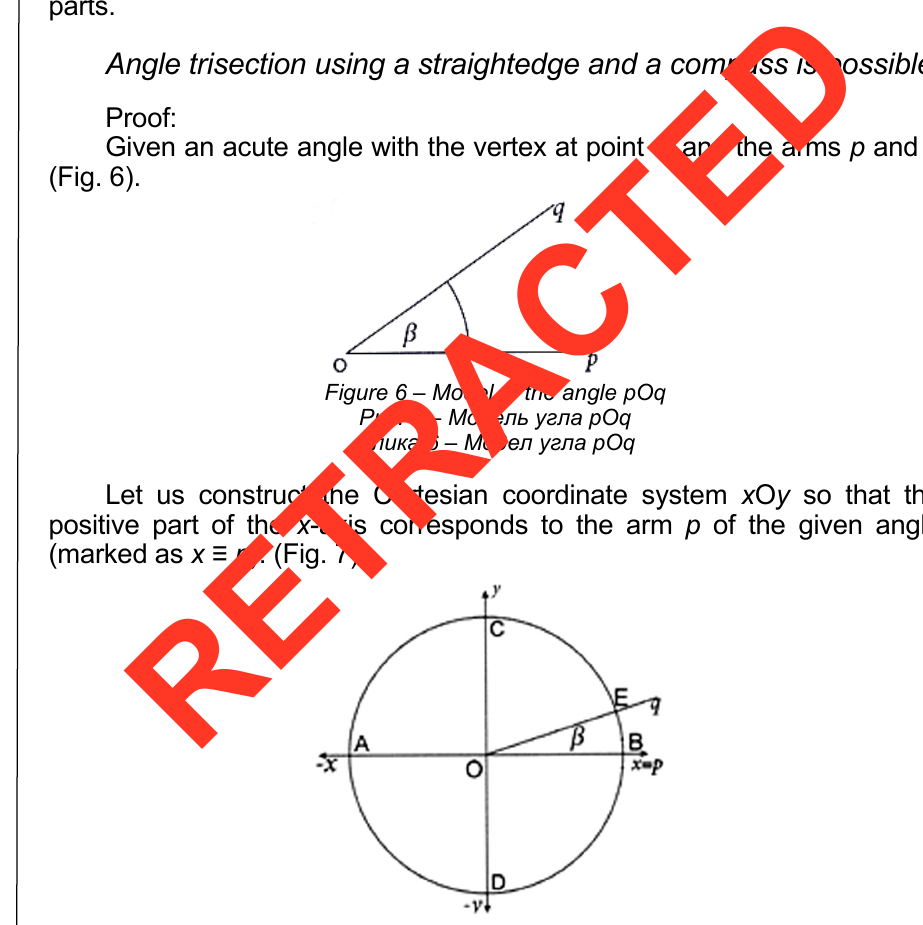
Figure 6 – Model of the angle pOq Рис . 6 – Модель угла pOq Слика 6 – Модел угла pOq